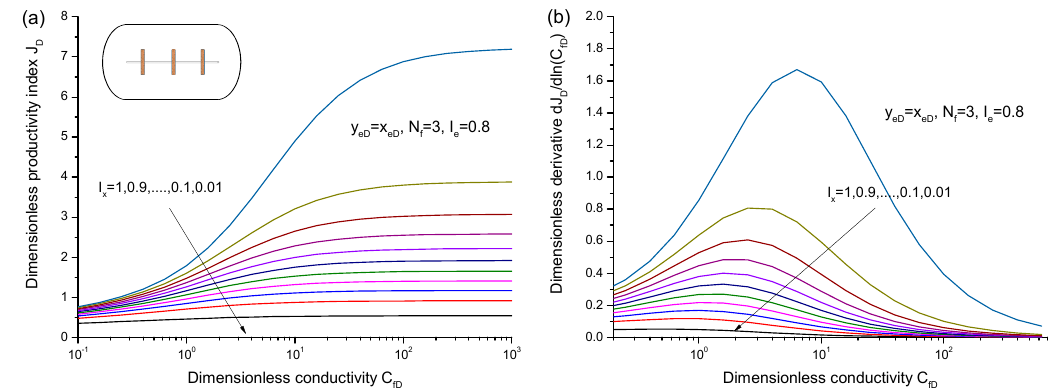
Figure 7. Productivity-index behavior of multiple fractures, including ( a ) the productivity index vs. dimensionless conductivity, and ( b ) the derivative of productivity index vs. dimensionless conductivity.